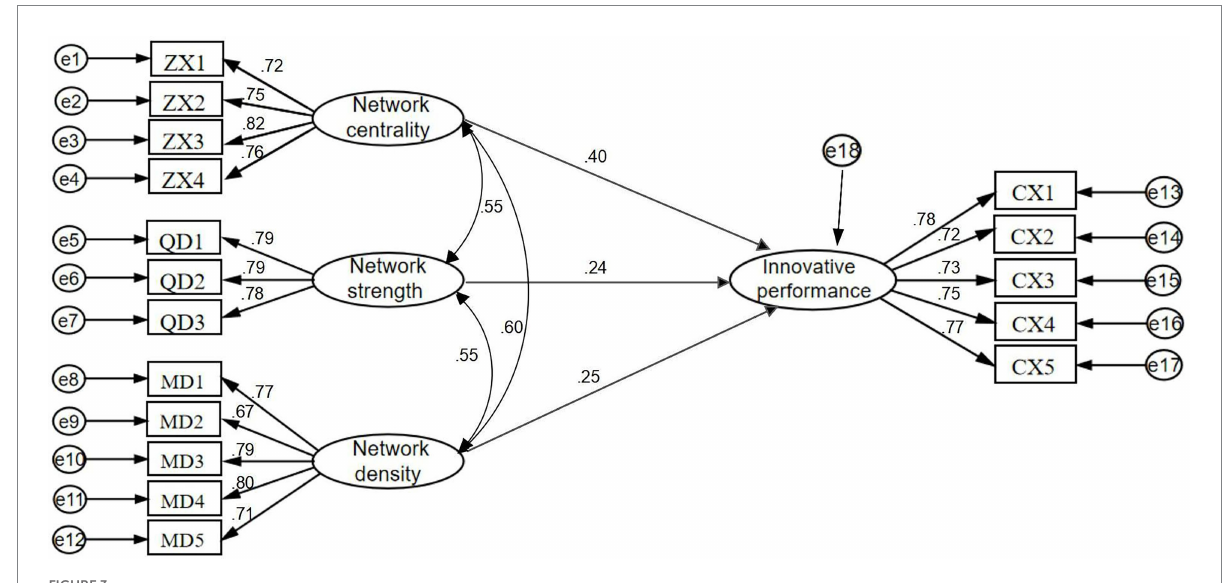
FIGURE 3 Structural equation path results.